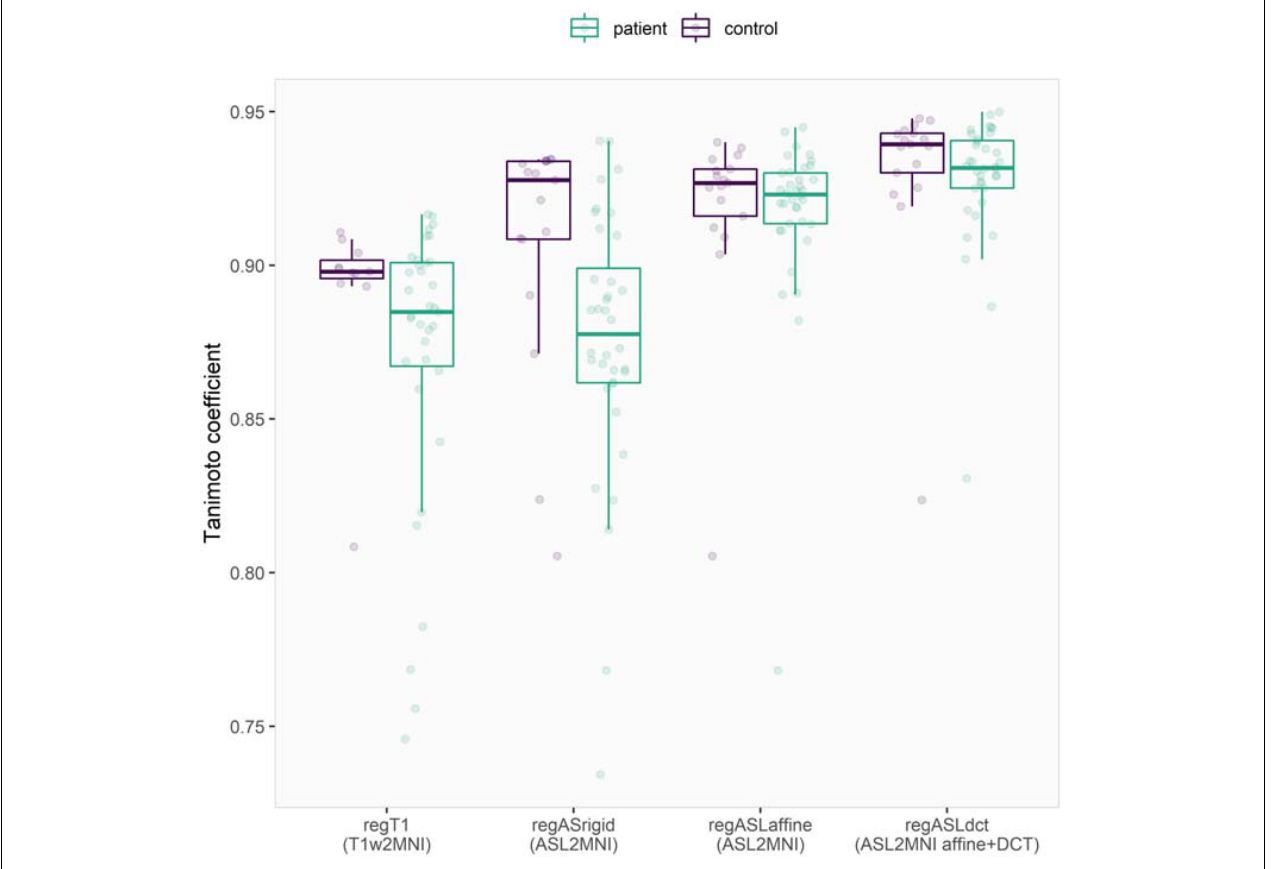
FIGURE 2 | Visualization of the Tanimoto coefficient of the four registration types in patients and controls. The dots represent the original data, while the boxplots show the 25, 50, and 75% quantiles. The whiskers reach to a maximum of 1.5 times the IQR.